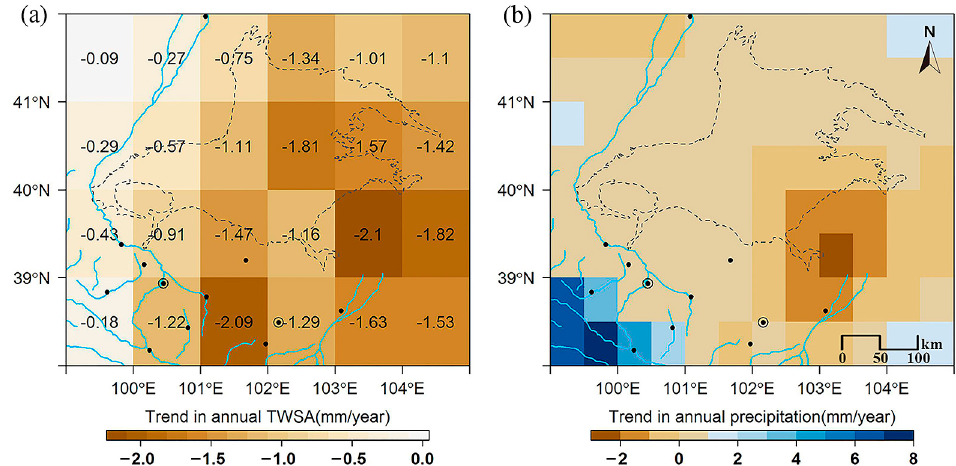
Figure 4. ( a ) Spatial trends in annual TWSA from 2001 to 2014; ( b ) and in annual precipitation from 2001 to 2014 over the BJD study area. The blue lines represent rivers and the gray dashed lines stand for the boundary of the BJD.